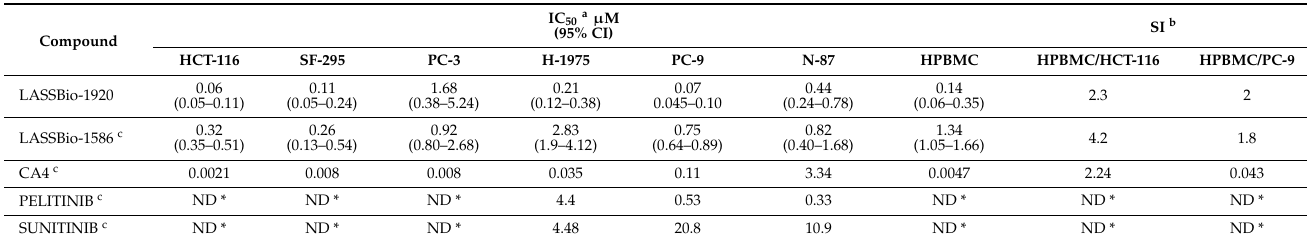
a Data are presented as half-maximal inhibitory concentration (IC 50 ) in µ M and 95% confidence intervals (95% CI) for human tumor cell lines with normal EGFR expression (HCT-116, colon carcinoma; SF-295, glioblastoma; PC-3, prostate adenocarcinoma), human tumor cell lines with overexpression of EGFR (H-1975, non-small cell lung adenocarcinoma; PC-9, lung adenocarcinoma; and N-87, gastric carcinoma), and human non-tumor cells (HPBMC, human peripheral blood mononuclear cells) obtained from three independent experiments performed in triplicate. IC 50 was calculated using Prism 6.0 (GraphPad/Intuitive Software for Science, San Diego, CA, USA). Viability data were normalized to the control group (DMSO, 0.5% in medium). b Cytotoxic selectivity index (SI) represents IC 50 for HPBMC/IC